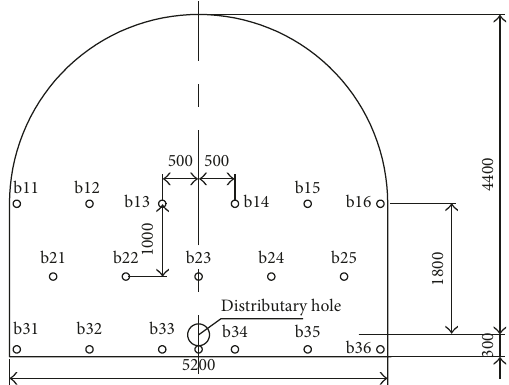
Figure 4: Layout of the construction well